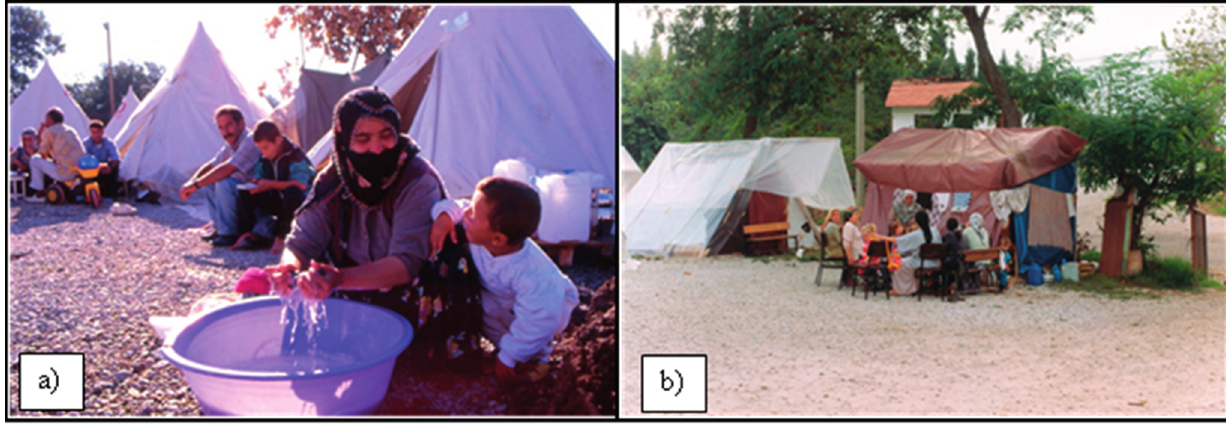
Figure 4. Women continue their struggle for survival after earthquakes; ( a ) a woman with children in a tent city in the Van earthquake [26]; ( b ) women’s compliance during post-disaster rehabilitation after the earthquakes in Gölcük-Kocaeli and Adapazar ı